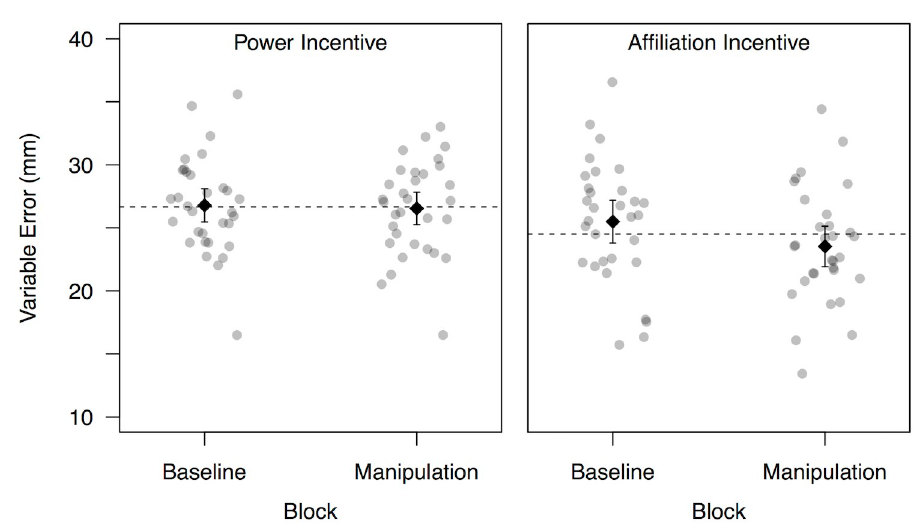
Fig 1. Variable error by block and condition. The influence of experimental block (baseline, experimental) and manipulated incentives (power, affiliation) on participants’ variable error in darts (less error = better performance). Dotted line indicates mean for each incentive, diamonds indicate block means with error bars for 95%